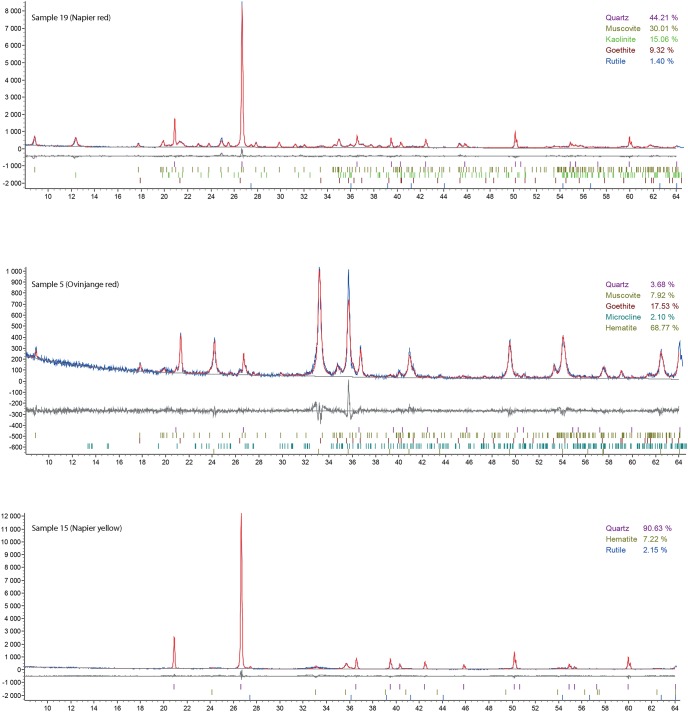
XRD spectra recorded for ochre samples 5 (Ovinjange fine ground ochre powder), 15 (Napier medium hard red shale chunk) and 19 (Napier soft yellow limonite chunk).